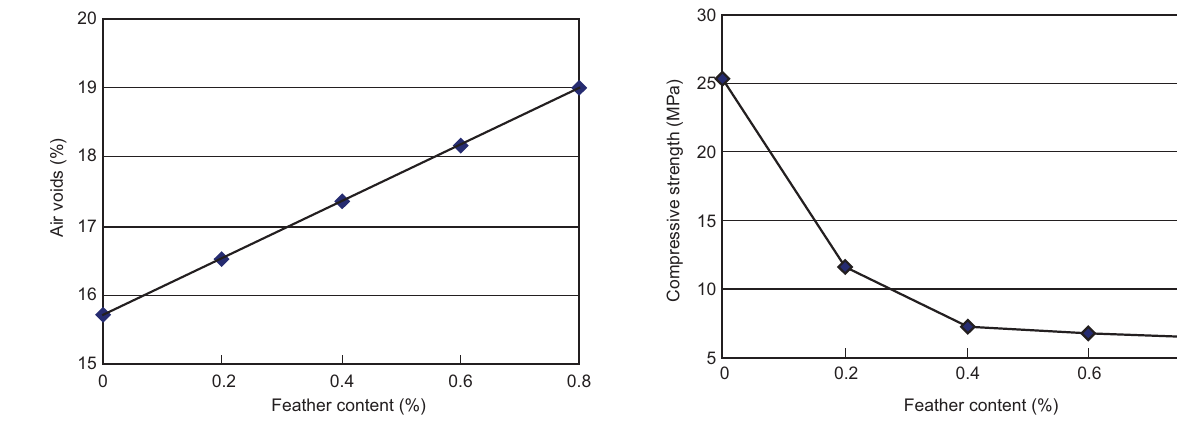
Figure 6 Compressive strength of hardened mortar cubes as a function of feather fiber content.